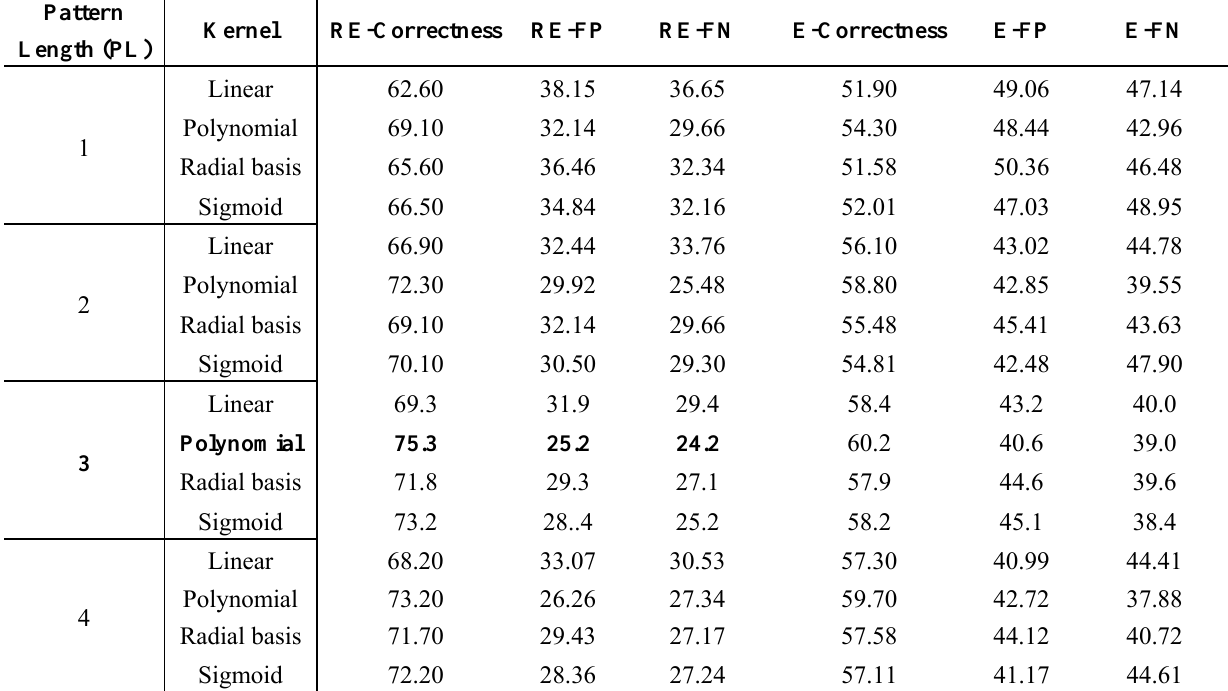
Table 3. Experimental results of SVM classifier